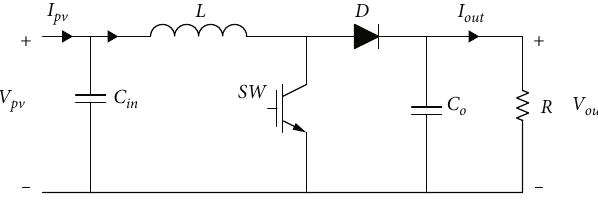
Figure 5: Circuit diagram of the DC-DC boost converter [49]. Table 2: Characteristics of the DC-DC converter. Converter